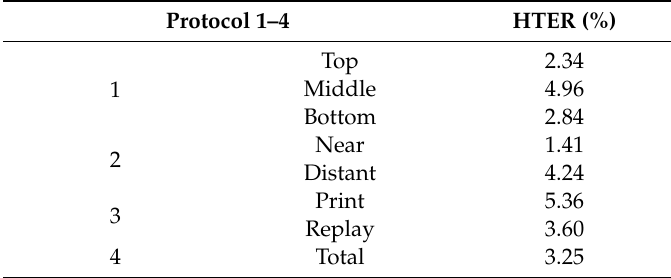
Table 4. The half total error rate HTER of the ResNet-18 model using PR-FSAD.